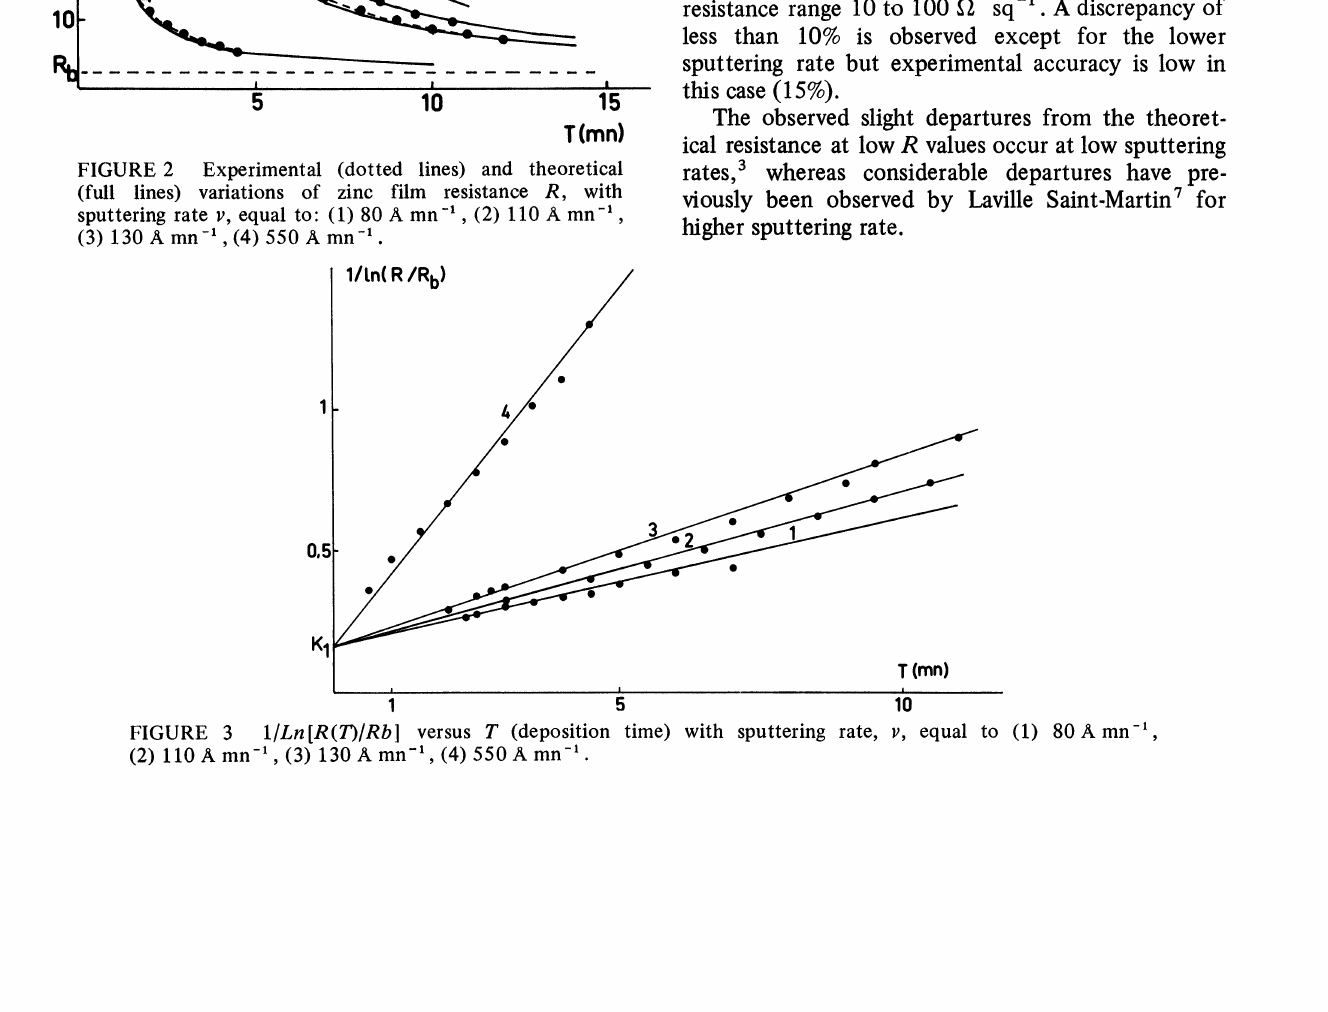
I/Ln[R(T)/Rb] versus T (deposRion time) with sputtering rate, -, (4) S50 A (2) t0 A mn (3) 30 A mn